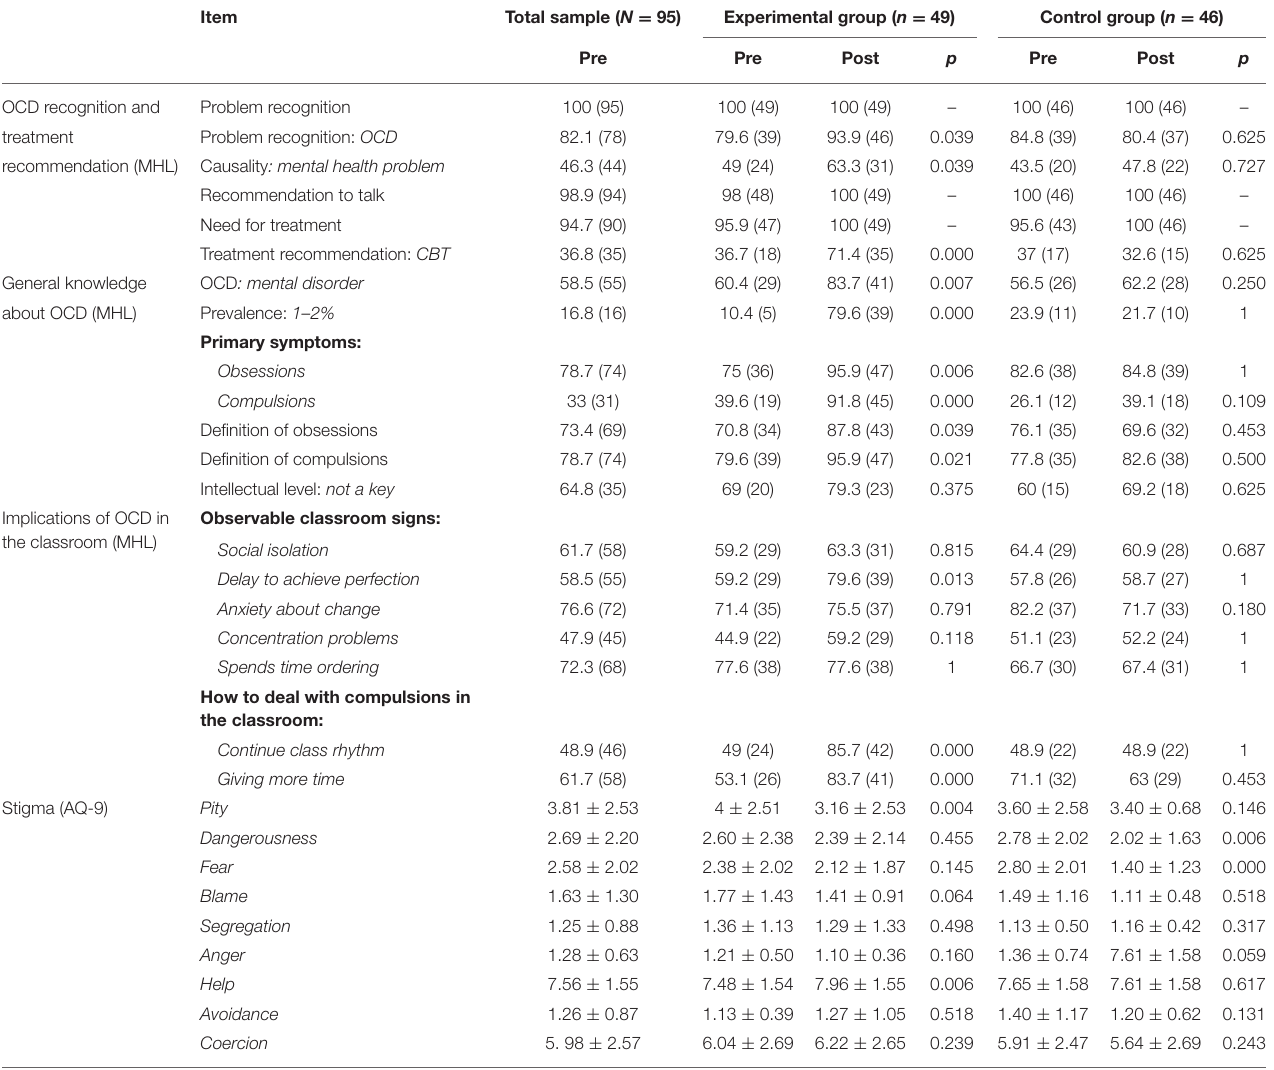
TABLE 1 | Descriptive statistics of OCD recognition and treatment, general knowledge about OCD and its implications in the classroom and the stigma related to OCD, and comparison of these variables before (pre) and after (post) the intervention in the experimental and control groups.